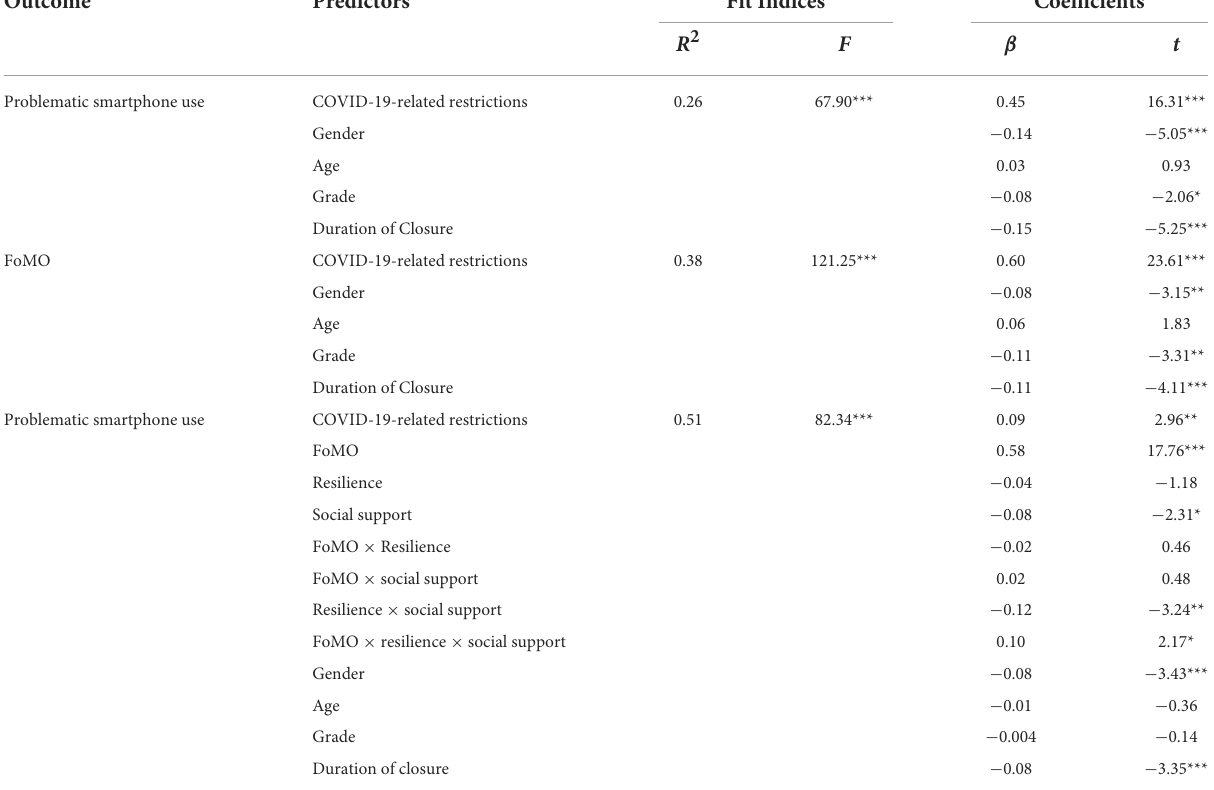
TABLE 3 The moderated moderated mediating tests of problematic smartphone